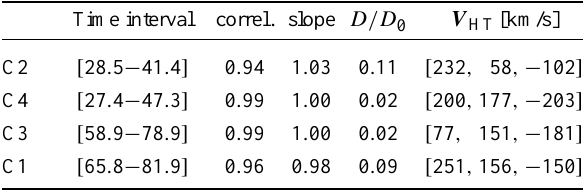
Table 4. Results from the HT analysis. For each satellite one shows the interval of analysis (in seconds from 07:36:00UT), the correla- tion coefficient and the regression line slope between the electric field in the starting reference frame E i and the convection electric field E HT = − V HT × B , the ratio D/D 0 expressing the fraction of E i remained un-transformed in the HT frame, and the three com- ponents of the HT velocity, V HT , in